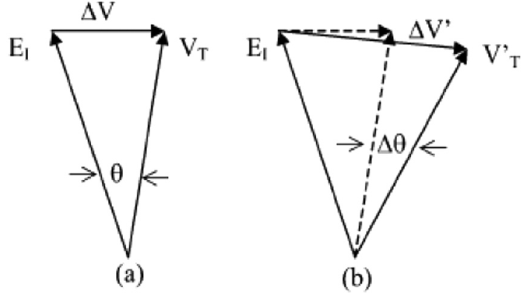
Figure 2: Vector phase diagram: ( a ) load angle before islanding; ( b ) displacement in the loading angle during islanding [ 41 ] .